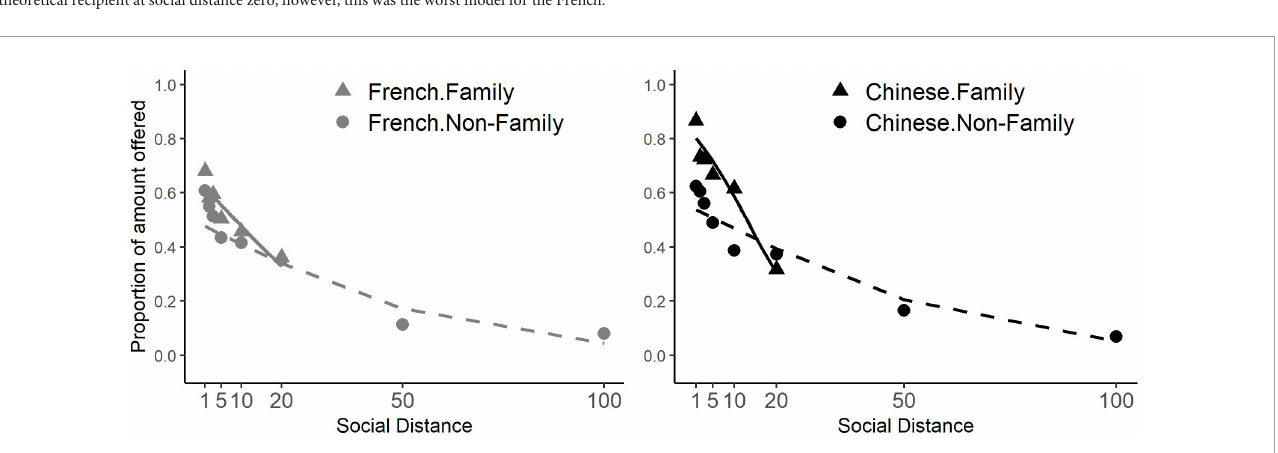
FIGURE4 Interaction effect between group family relations and social distance on generosity at social distances 1 ∼ 100. The solid lines show the proportion of the endowments offered by participants to family members, for the French ( left graph, blue), and the Chinese ( right graph, red) as estimated by GLM3. The dotted lines represent the proportions of the endowments offered to non-family members. The solid triangles show the mean proportions of the endowments offered to family members for the Chinese and French. The hollow dots show the mean proportions offered to non-family members. At social distances 50 and 100 the participants did not know the recipients, who could not be family